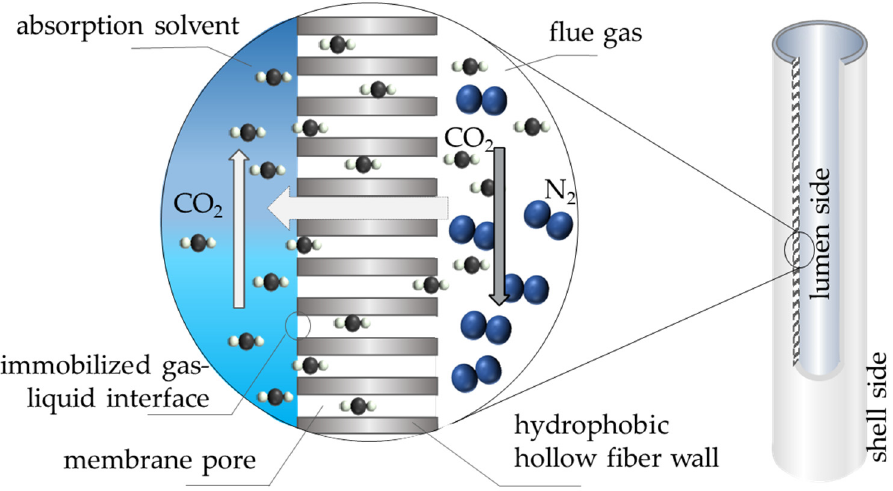
Figure 1. Schematic representation of a membrane contactor for CO 2 capture.